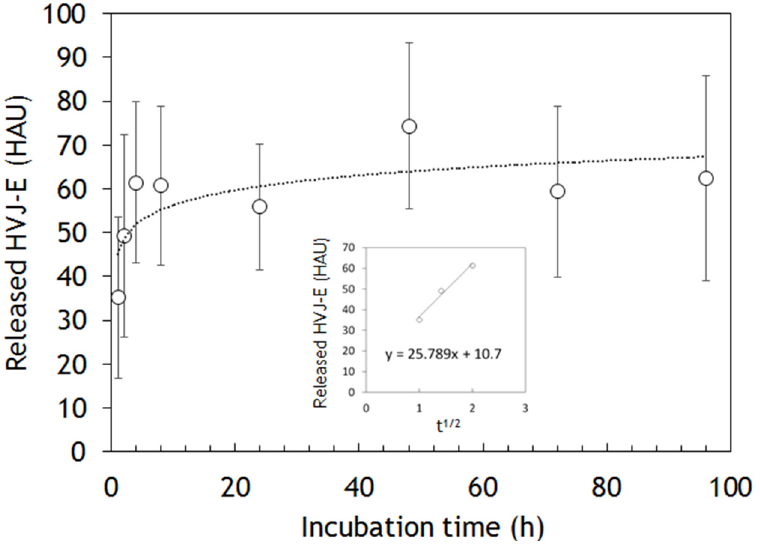
Figure 5. The HVJ ‐ E release kinetics from nanofiber meshes measured by UV ‐ vis. The inserted graph plots the released HVJ ‐ E against the square root of a time.